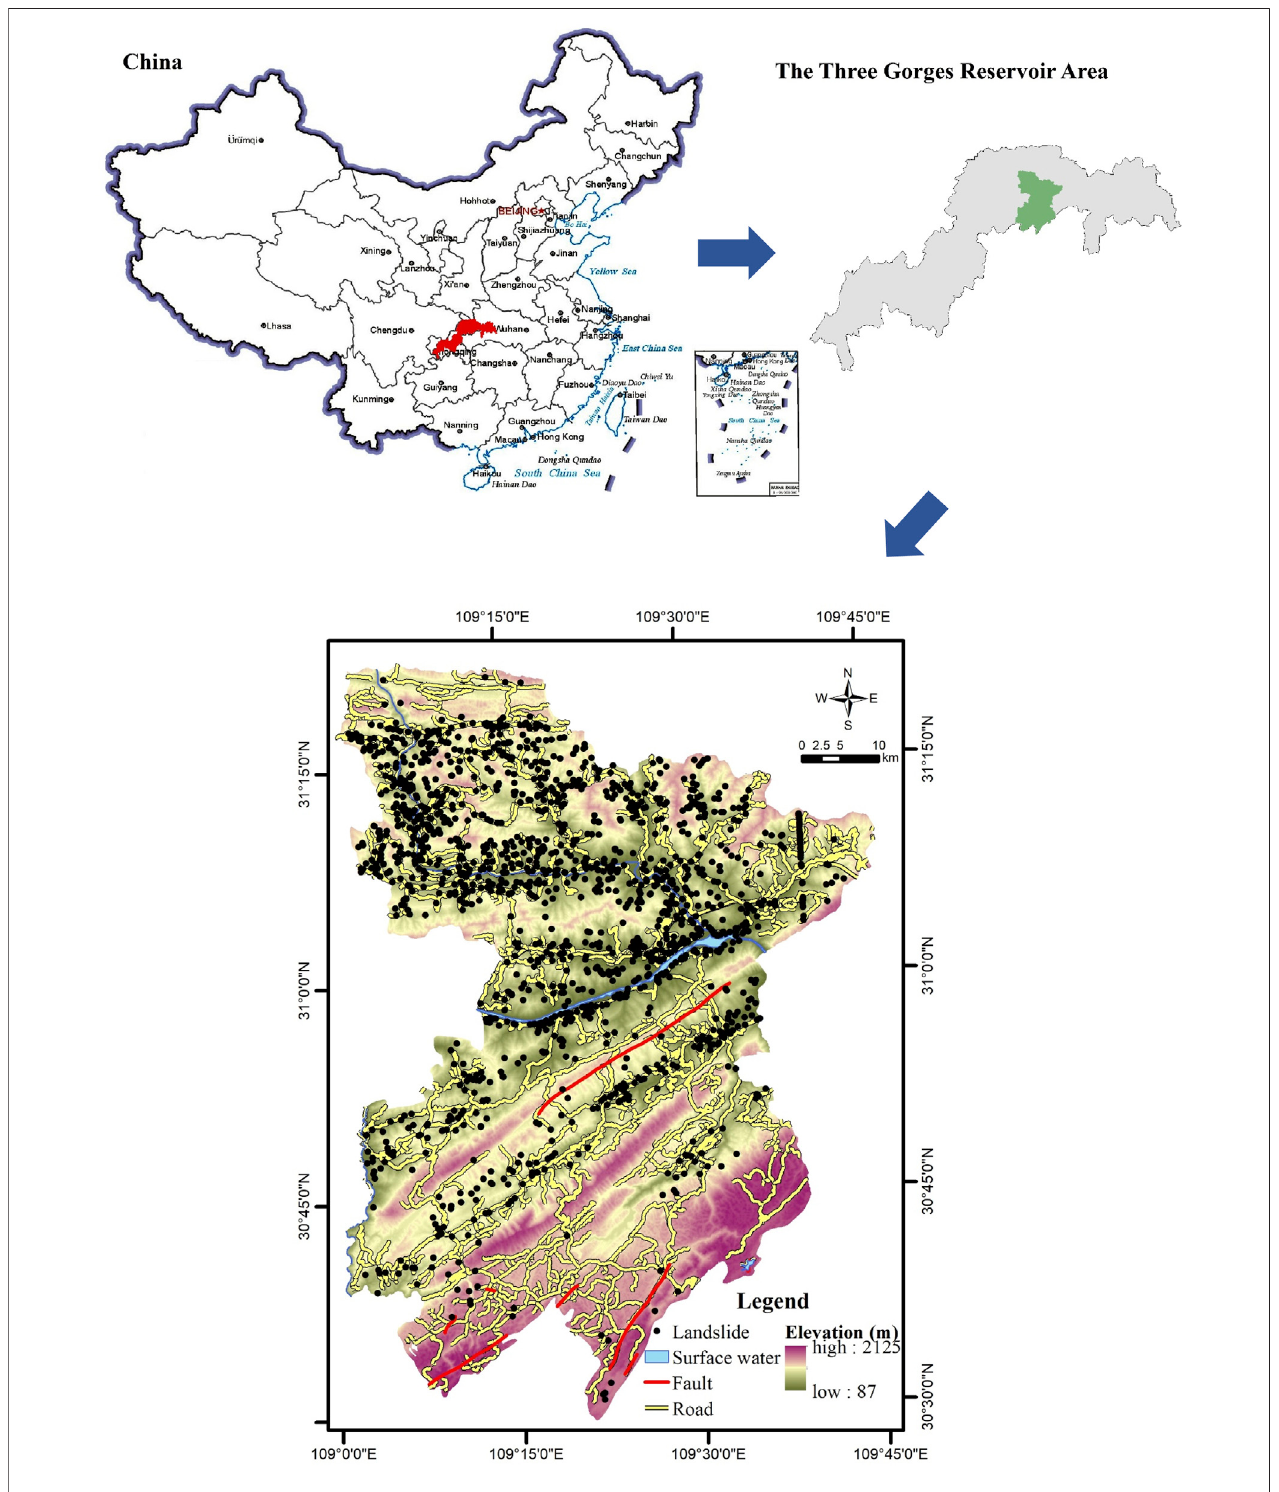
FIGURE 1 | Location of the study area.